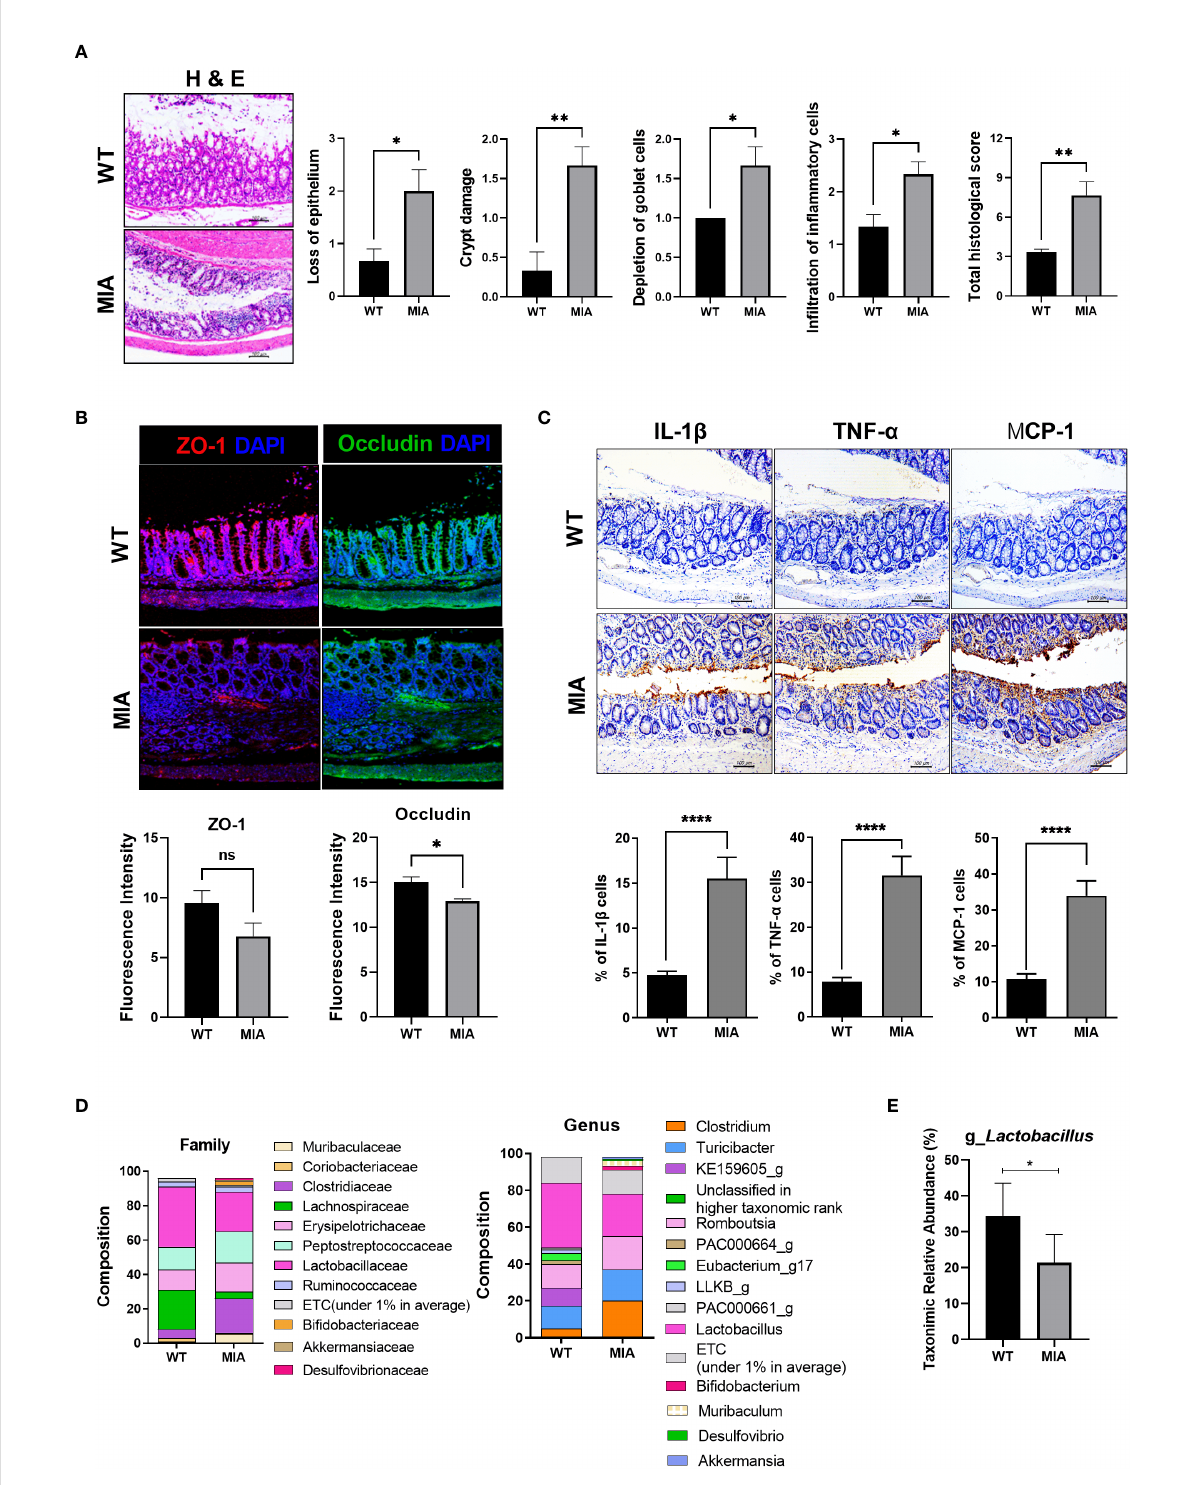
FIGURE 1 Osteoarthritis (OA) leads to an imbalanced intestinal environment and an altered microbiome. (A) Intestinal epithelial tissue images of the healthy (WT) and diseased (monosodium iodoacetate, MIA) groups at 3 weeks after OA induction (magni fi cation ×200). (B) Intestinal tight junction protein expression (magni fi cation ×200). (C) Expression of in fl ammatory factors by immunohistochemistry (IHC) (magni fi cation ×200). (D) The microbiome of fecal samples in WT and MIA. (E) The abundance of Lactobacillus in WT and MIA. Data are means ± SD (* p < 0.05, ** p < 0.01, **** p < 0.001), ns, not signi fi